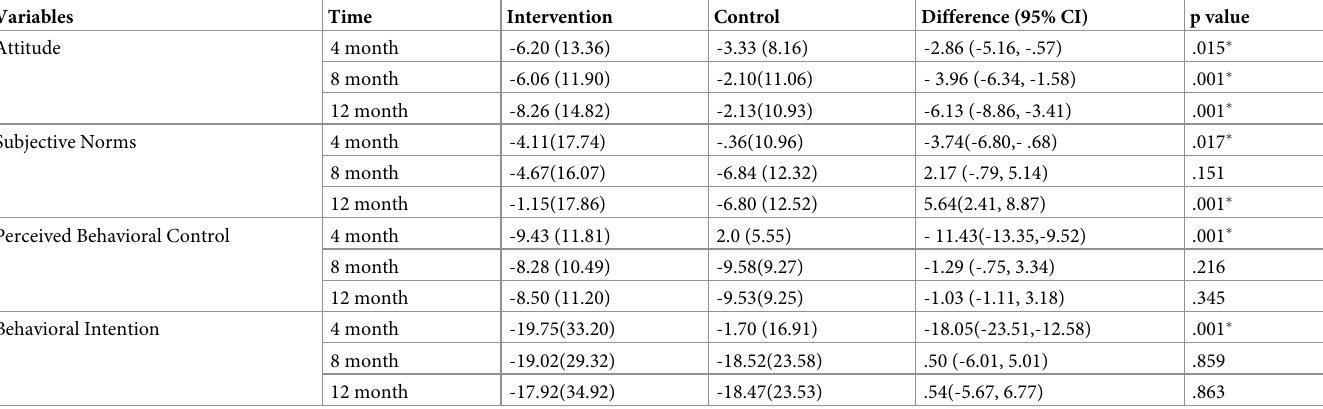
Table 6. Mean changes in constructs of theory of planned behavior intent to perform breast self-examination by time and group (n = 360).